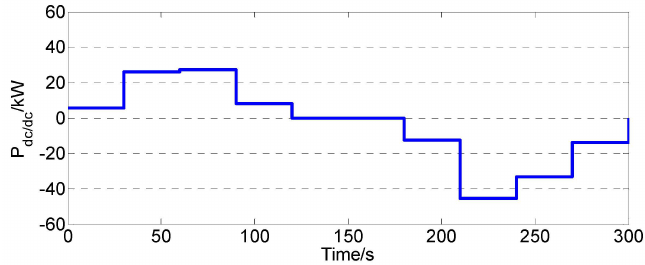
Figure 29. The simulation results when the UC bank voltage is 600 V.